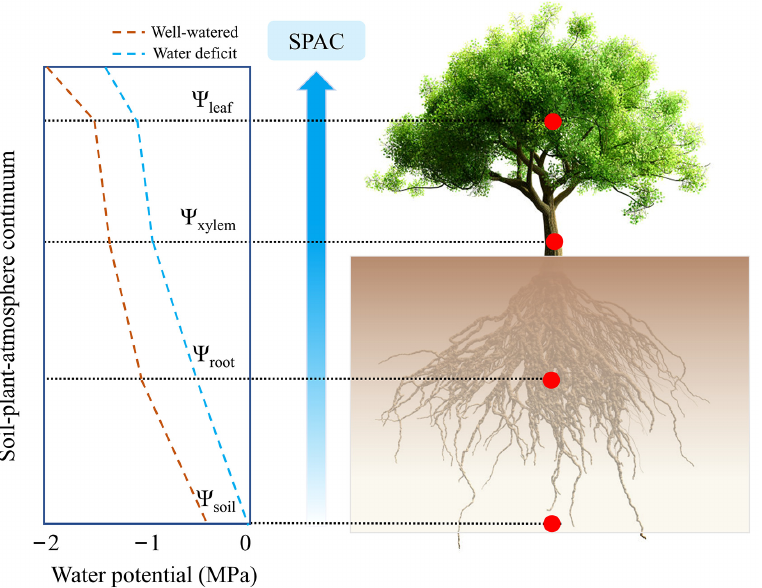
Figure 5. Soil-plant-atmosphere continuum (SPAC) water fluxes, adapted from Scharwies and Dinneny [101] and Boanares et al. [102]. Dinneny [101] and Boanares et al.